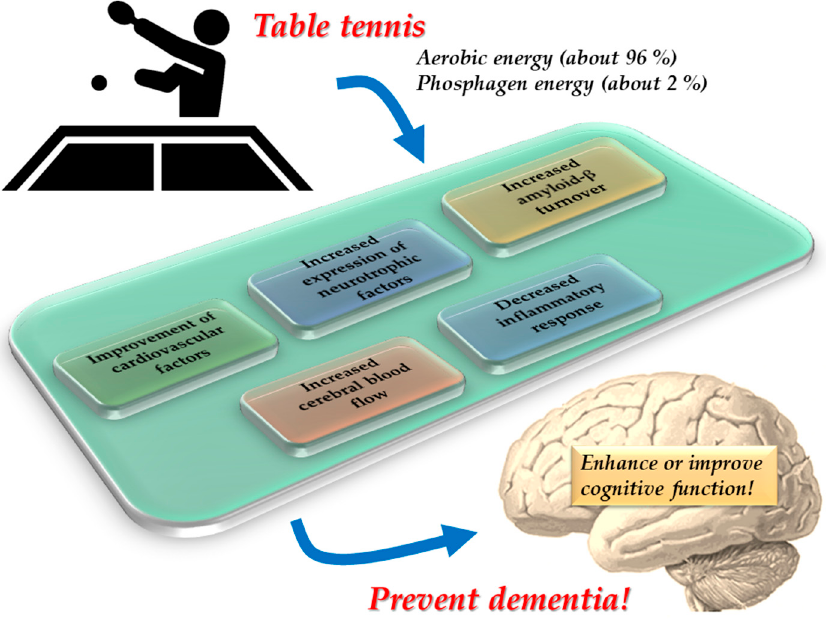
Figure 1. Possible mechanism of prevention of cognitive decline and dementia through table tennis.